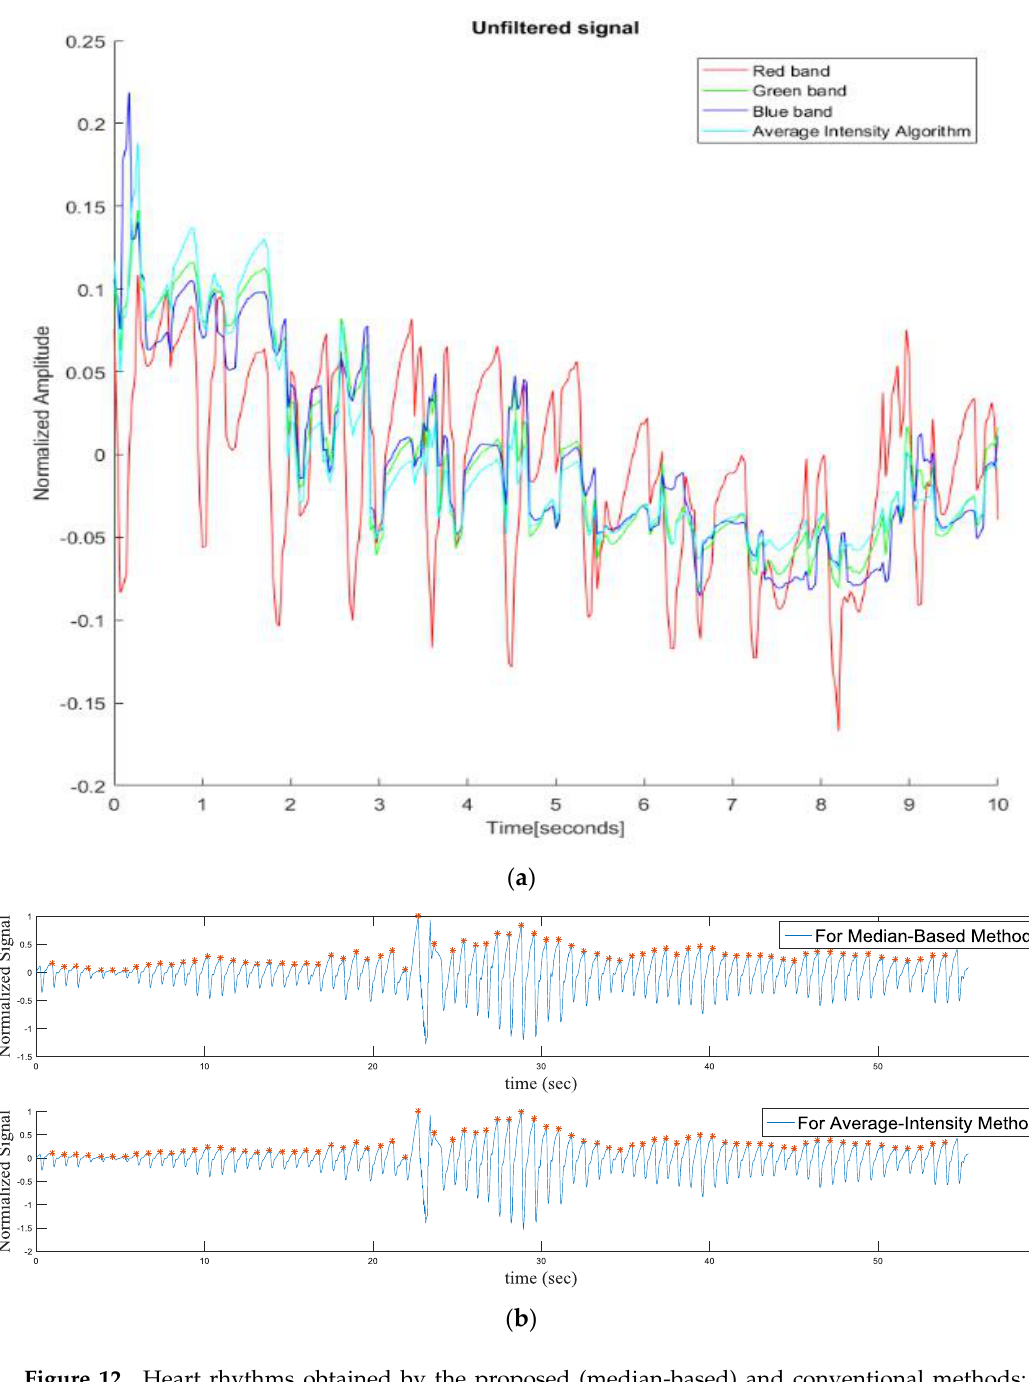
Figure 12. Heart rhythms obtained by the proposed (median-based) and conventional methods: ( a ) heart rhythms from the conventional RGB band-based method and the proposed method; and ( b ) peak detection results from the conventional red band-based method and the proposed method.